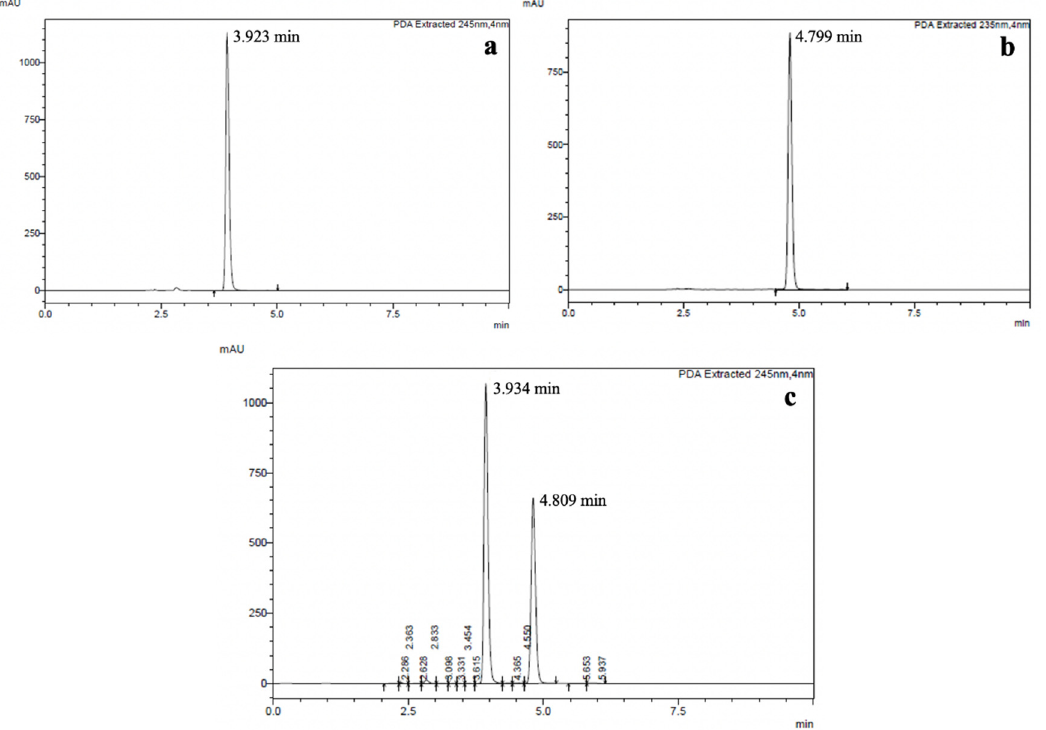
Figure 5. HPLC chromatogram of ( a ) salmeterol xinafoate, ( b ) fluticasone propionate, and ( c ) their mixture.